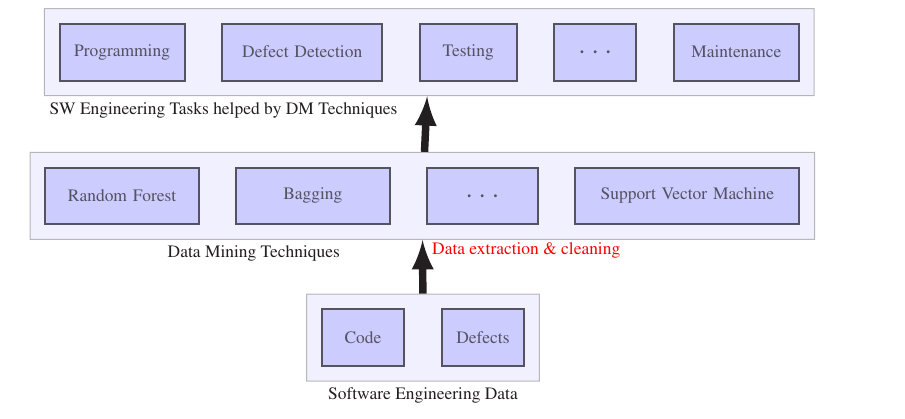
Figure 1. Data Mining and Software Engineering